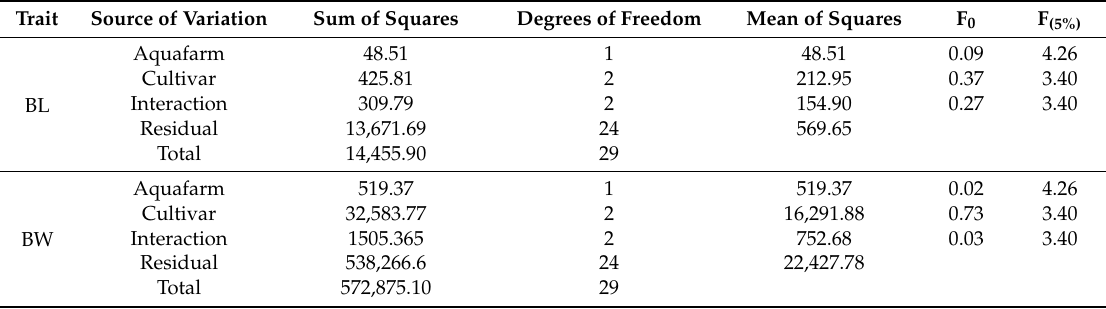
Table 5. Analysis of variance in phenotypic plasticity measurements—blade length (BL) and blade width (BW)—from three U. pinnatifida cultivars at Myeongcheon and Gyedo aquafarms between January and May